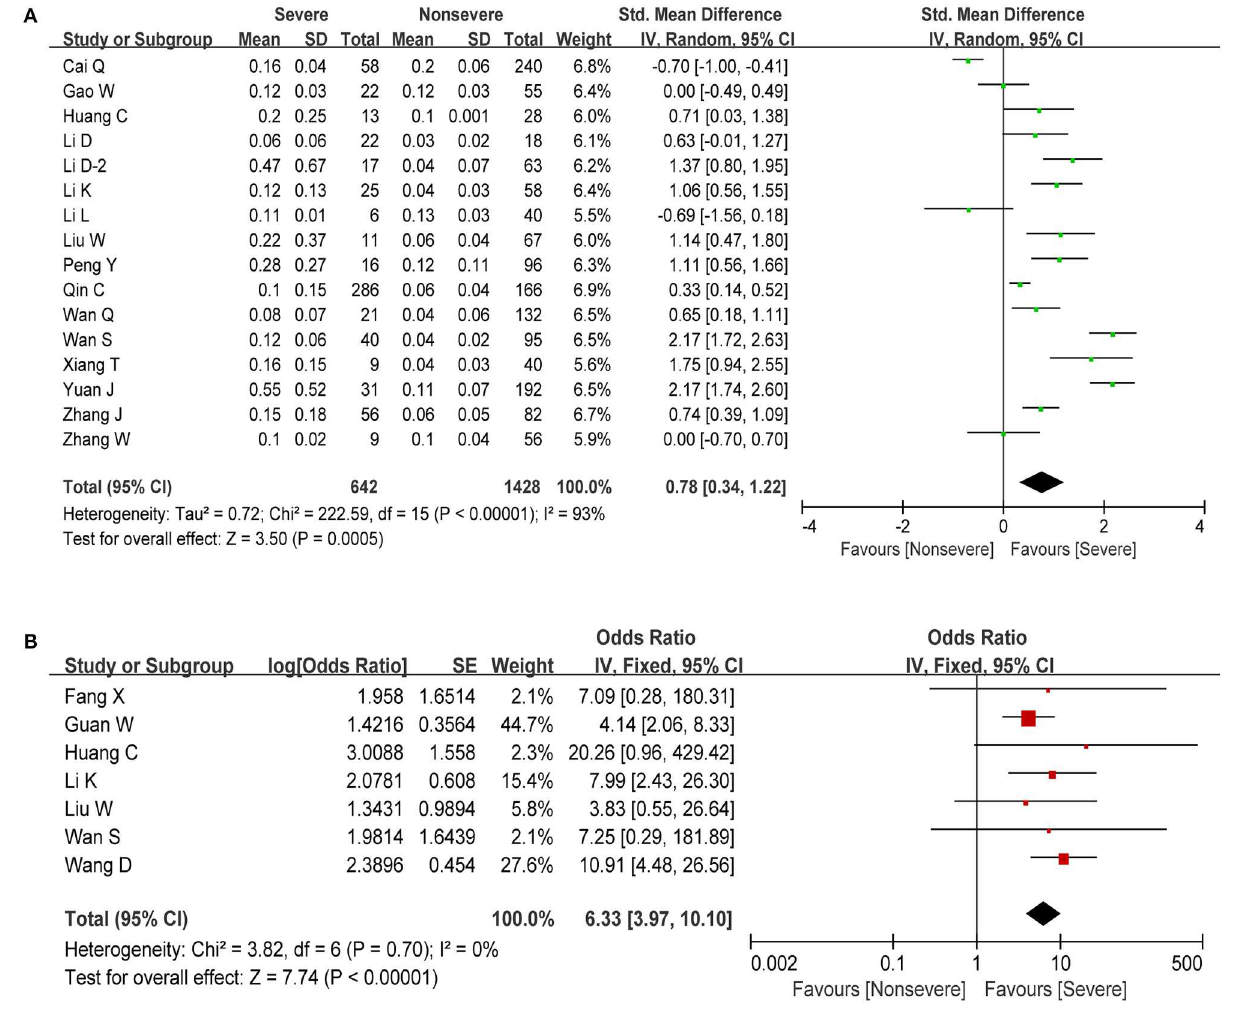
FIGURE 5 | Meta-analysis for PCT in COVID-19 cases. (A) Forest plot of comparison of the included studies. (B) Forest plot of OR for the correlation of elevated PCT with disease